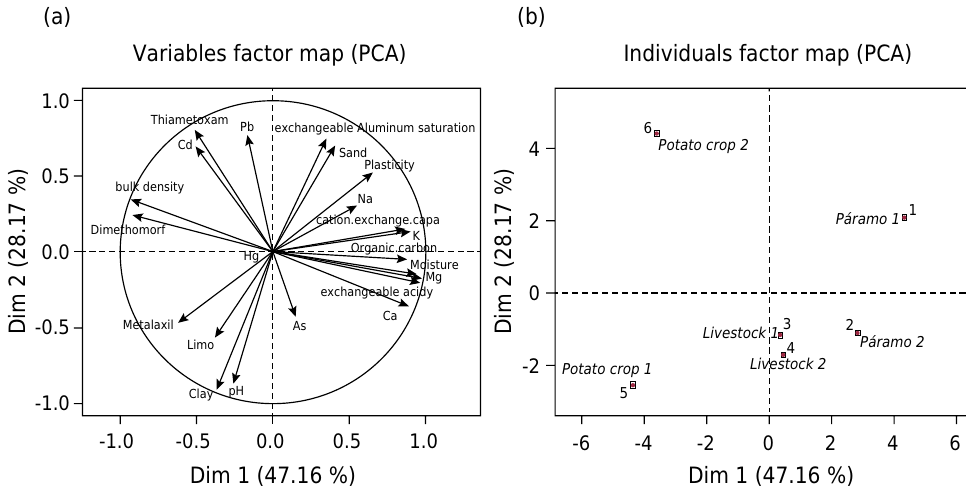
Figure 4. Analysis of principal components relating the physicochemical variables, heavy metals, and pesticides of soils under the Páramo , potato cultivation, and cattle farming (a); and individual map of the uses of the soils under Páramo , potato cultivation, and cattle farming